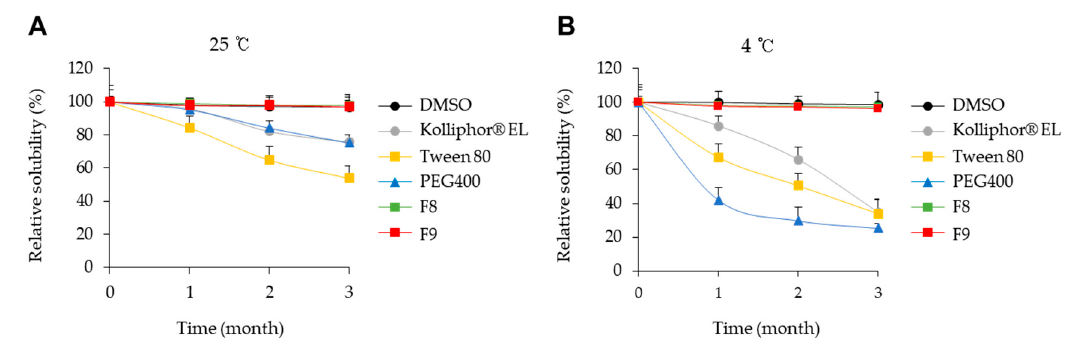
Figure 5. Time evolution of the concentration of KY19382 in F8 and F9 formulations. Concentrations of KY19382 at 25 °C ( A ) and 4 °C ( B ).